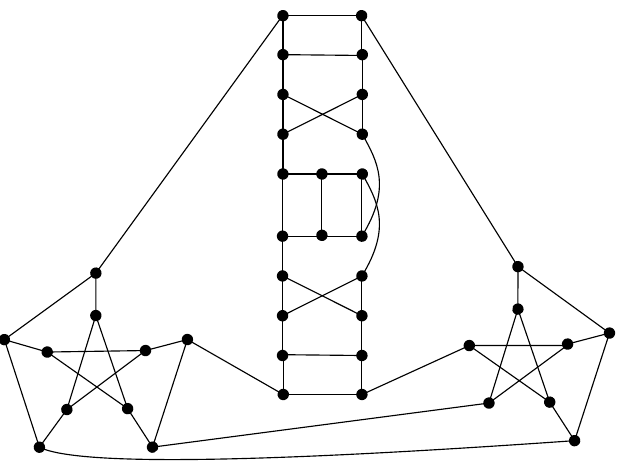
Fig. 6: One of the 11 smallest snarks of Type 2 obtained by a junction of the bricks on Figure 2 and Figure 3.